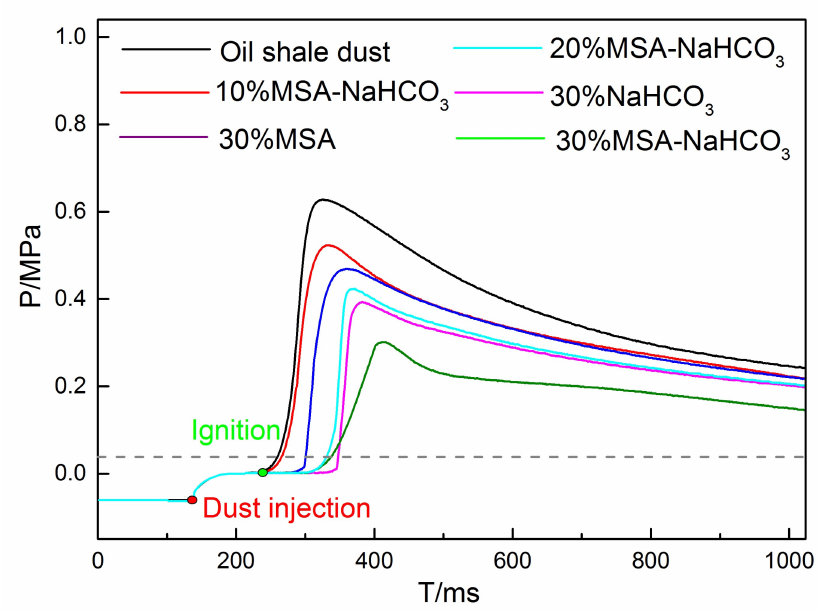
Figure 9. Suppression characteristics of explosion inhibitors on the explosion pressure of oil shale dust in a 20 L closed space.